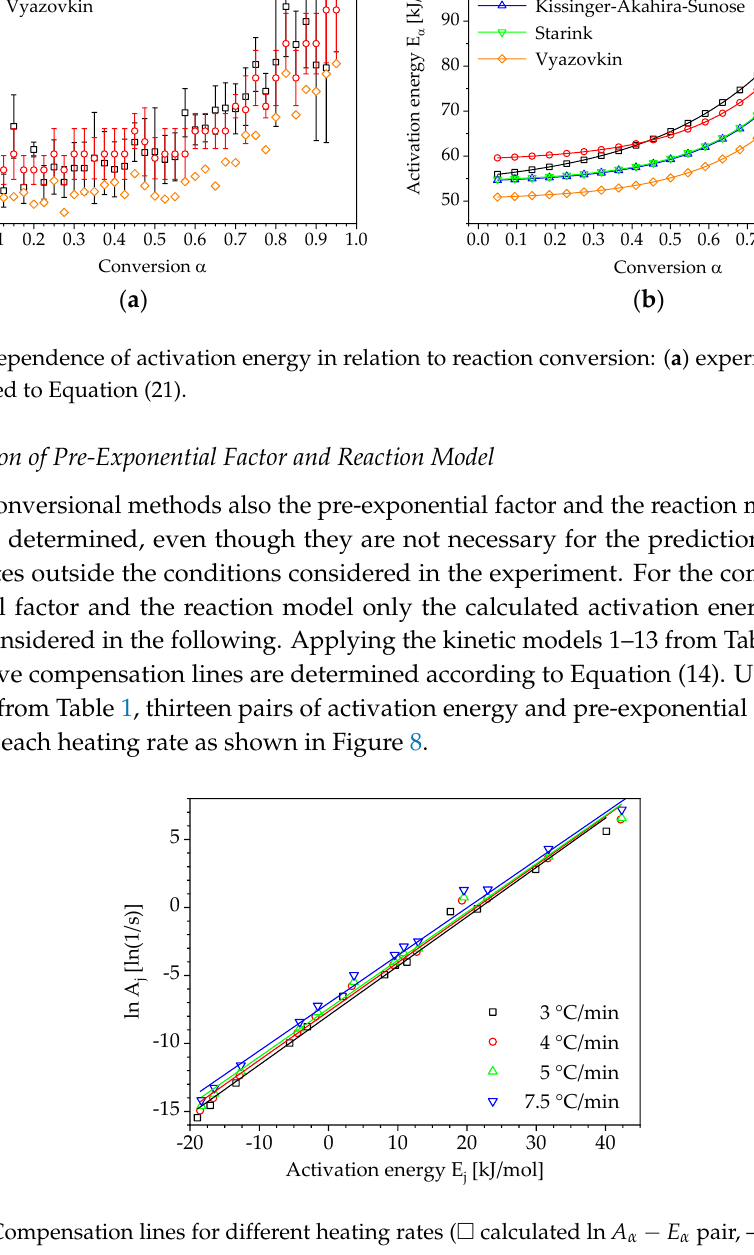
( d ) Figure 6. Isoconversional plots according to: ( a ) Friedman; ( b ) Flynn-Wall-Ozawa; ( c ) Kissinger- Akahira-Sunose; ( d ) Starink. The corresponding conversion-dependent activation energy can be determined from the slopes of these lines. Figure 7a shows the activation energies obtained using a differential (Friedman) and integral (Flynn-Wall-Ozawa) isoconversional method. In addition, the plot shows the course of the activation energy, calculated according to Vyazovkin using numerical integration and an algorithm for minimization of Equation (13). The resulting plots can be approximated by the following